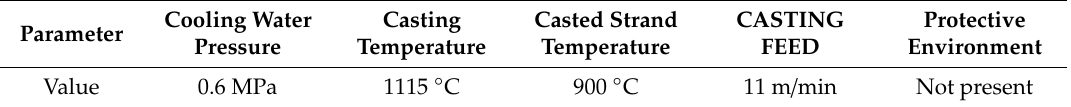
Table 1. Table 1. Continuous casting parameters of ETP grade copper strand. Table 1. Continuous casting parameters of ETP grade copper strand.